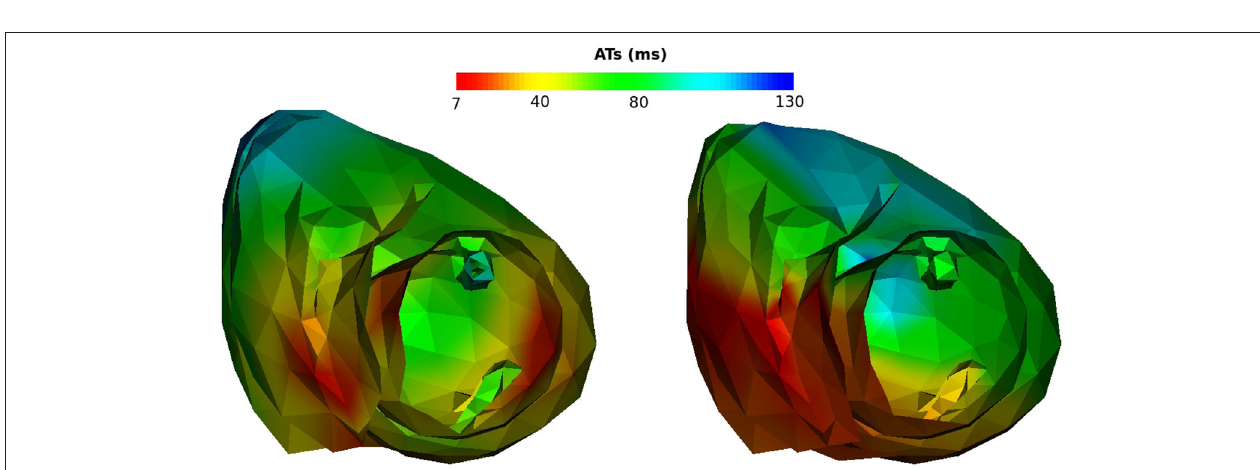
FIGURE 11 | Activation maps on Mesh2 , SR case. Left : reference activation map, right : reconstructed activation map.